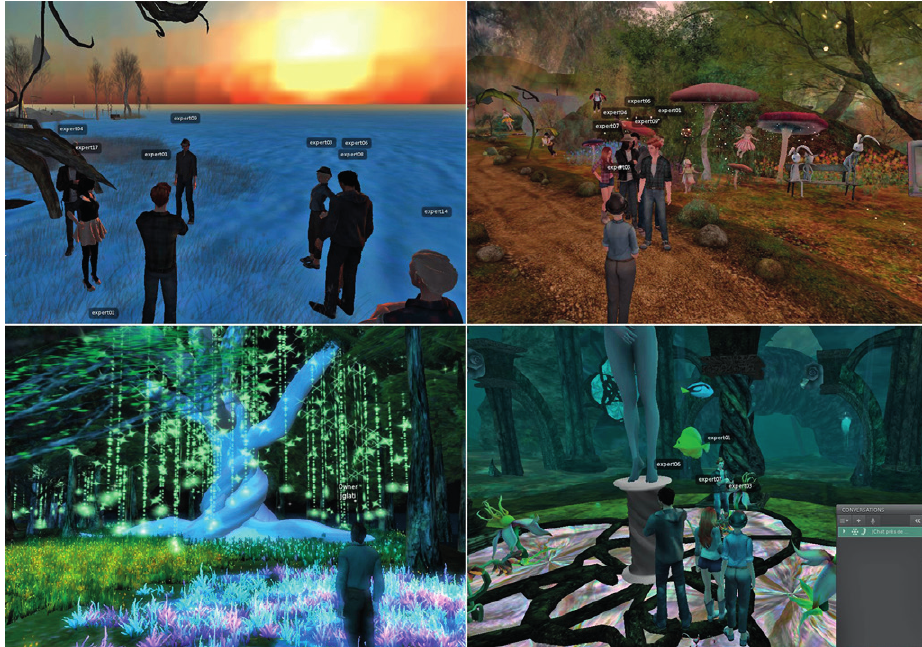
Figure 1. Screenshots of the virtual places used during the workshop and avatars of the participants (source: created by